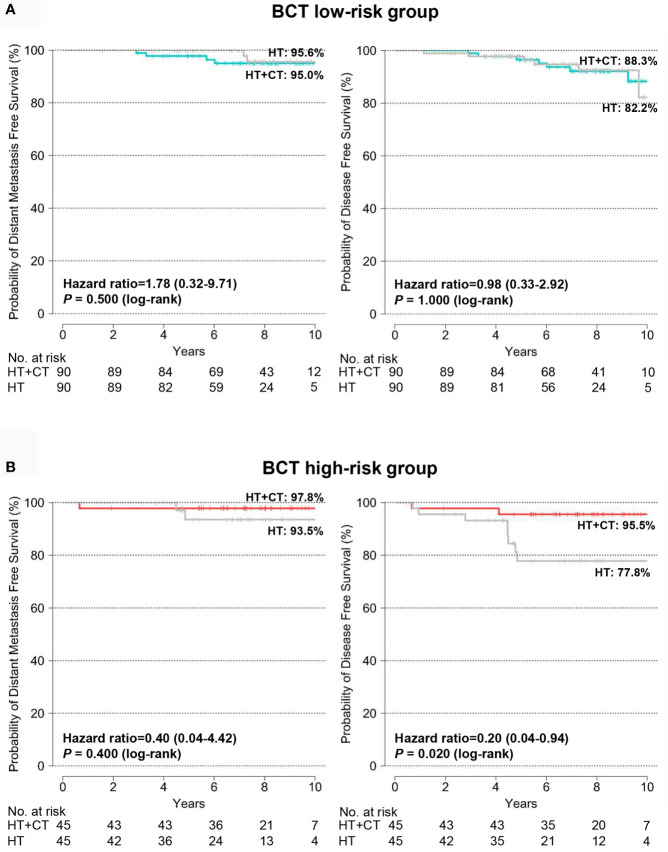
Kaplan-Meier estimates of 10-year distant metastasis-free survival and disease-free survival according to treatment group in the PSM cohort. (A) BCT low-risk (n = 180) and (B) BCT high-risk (n = 90) group. Patients were treated with either hormone therapy alone (HT) or hormone therapy plus chemotherapy (HT+CT). PSM, Propensity score matching.